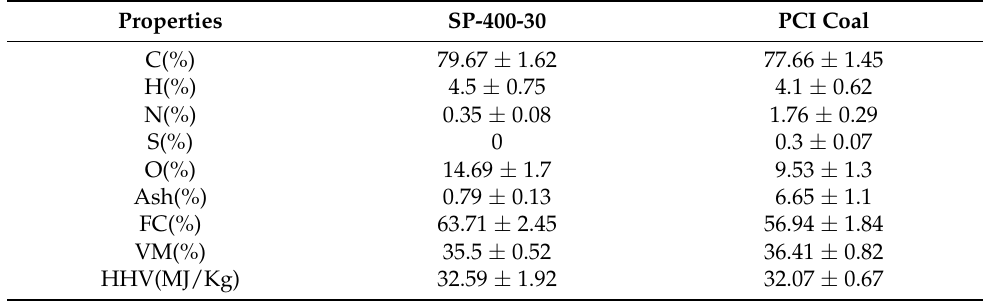
Table 7. Comparison of the physicochemical properties of selected pyro-biocarbon and PCI